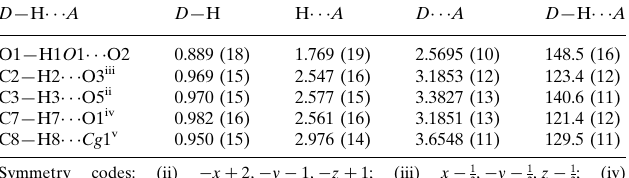
Hydrogen-bond geometry (A˚ , (cid:2) ). Cg 1 is the centroid of the C1–C5/C10